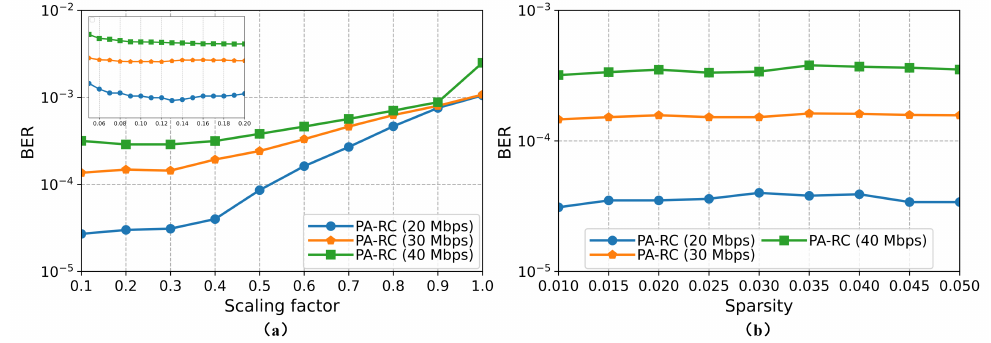
Figure 5. BER vs. parameters. ( a ) Scaling factor; ( b )